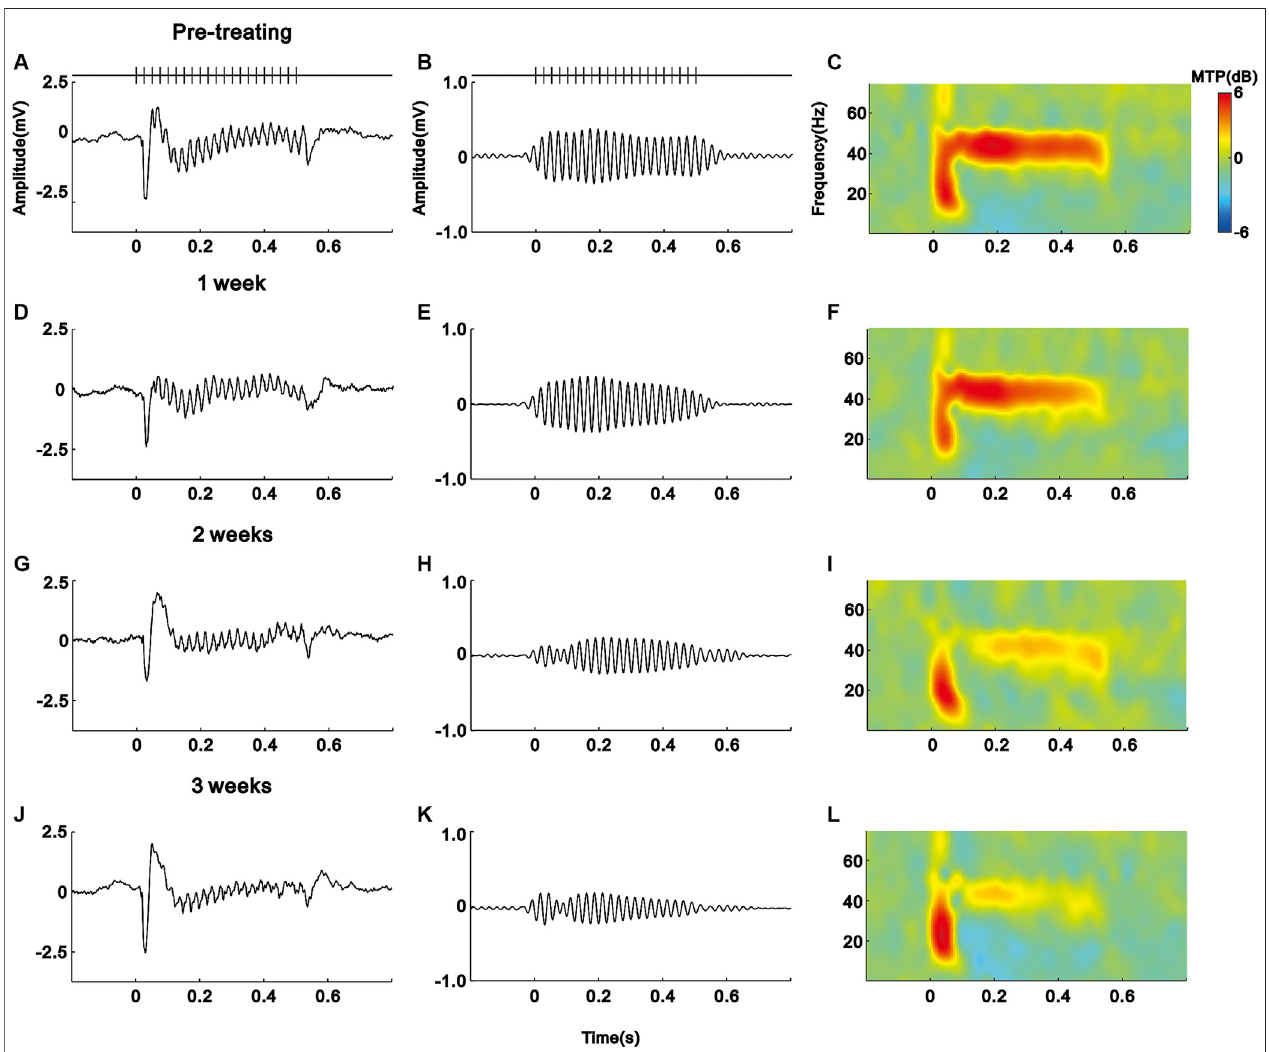
FIGURE 3 | IFN- α treatment reduces the ASSR of one example mouse. Same format as Figure 2 .